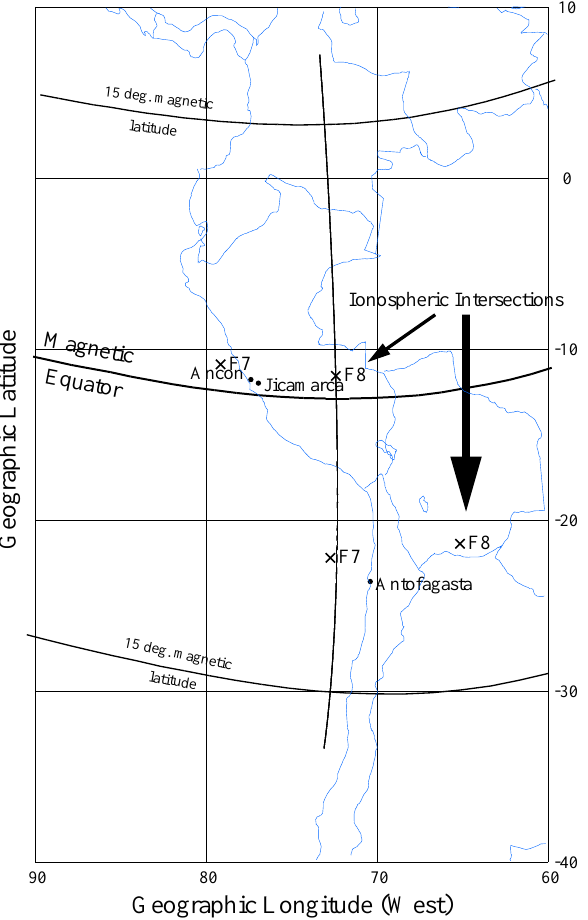
Fig. 1. Map of the west coast of South America showing the spaced- receiver sites at Ancon, Peru and Antofagasta, Chile, and the Julia radar at Jicamarca, Peru. F7 and F8 near Ancon indicate the 350-km ionospheric intersections of the Ancon-W and Ancon-E ray paths, respectively, to the F7 and F8 geostationary satellites. F7 and F8 near Antofagasta are the intersection points from Antofagasta to the same